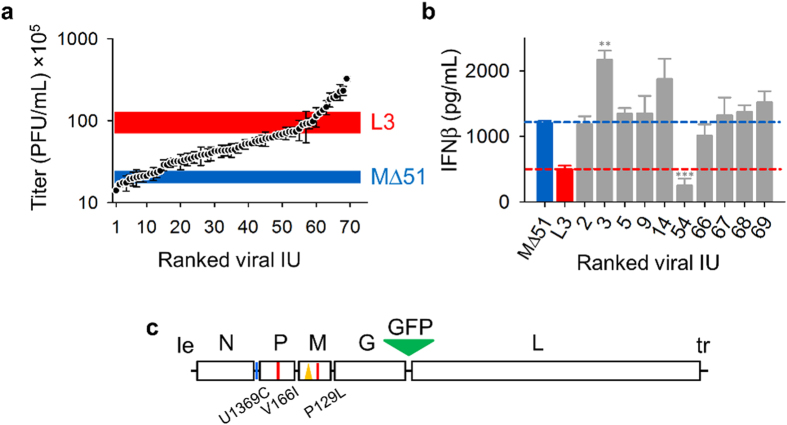
Viral yield and IFN suppression diversity within the L3 population.(a) For each of 69 IUs isolated by limiting dilution, the 24 h viral yield (±SEM, n = 3) in MRC-5 cells (MOI = 0.1 PFU/cell at inoculation) was determined. Clones are sorted according to yield rank. The blue and red thick lines indicate the yield (the width of the lines indicates the SEM, with n = 3) of the founder virus and the L3 population under the same assay conditions, respectively. (b) Quantitation of IFN-β secretion in a single infection cycle (MOI = 3 PFU/cell, 16 hpi) by ELISA. The red and blue bars and dashed lines indicate the values of the founder and L3 population, respectively. Error bars indicate the SEM (n = 3), and asterisks show the statistical significance of a t-test comparing each IU against the founder (***P < 0.001). IU numbers correspond to their viral yield rank in panel a. (c) Full-length genome sequence of the c54 isolate. Symbols are as in Fig. 2.